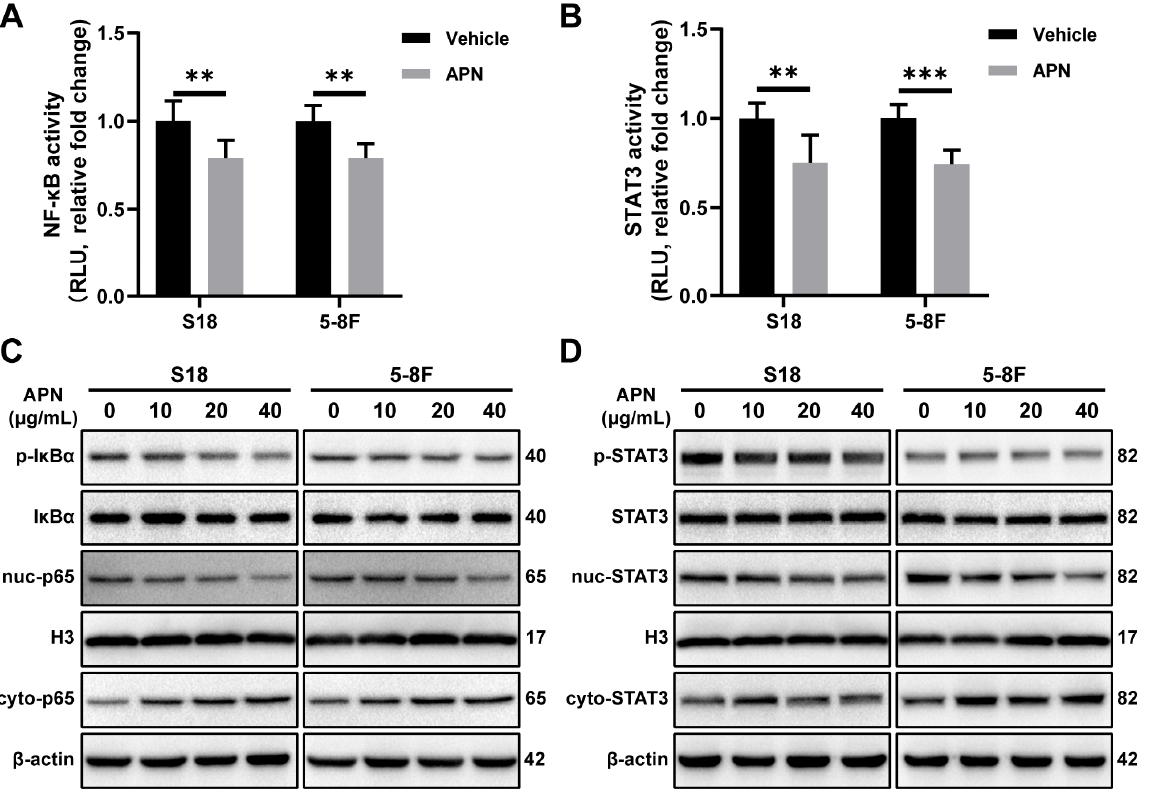
Figure 4. Adiponectin inhibits NF- κ B and STAT3 activation in NPC cells. Luciferase reporter assay of NF- κ B ( A ) and STAT3 ( B ) in S18 and 5-8F cells after treatment with 40 μ g/mL adiponectin for 3 h. ( C ) Western blot analysis of p-I κ B α , cyto-p65, and nuc-p65 in S18 and 5-8F cells after treatment with various doses of adiponectinfor 6 h. ( D ) Western blot analysis of p-STAT3, cyto-STAT3, and nuc-STAT3 in S18 and 5-8F cells after treatment with various doses of adiponectin for 6 h. Results are presented as mean ± SD of three independent experiments performed in triplicate. ** p < 0.01, *** p <